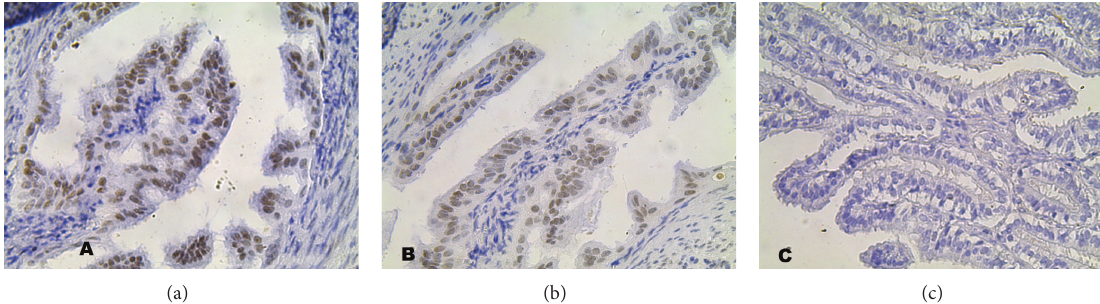
Figure 5: Expression of caspase 9 in the oviduct epithelial cells of the control group C and study groups A and B (mag. x400). The expression of caspase 9 was more intensive in the study groups than in the control group.